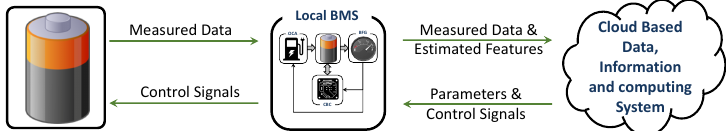
Figure 2. Cloud assisted battery management system. The abundance of todays connectivity allows crucial parameters related to SOC and SOH characteristics of battery packs in real-time. (image from Reference [49] being reprinted with permission from IEEE).